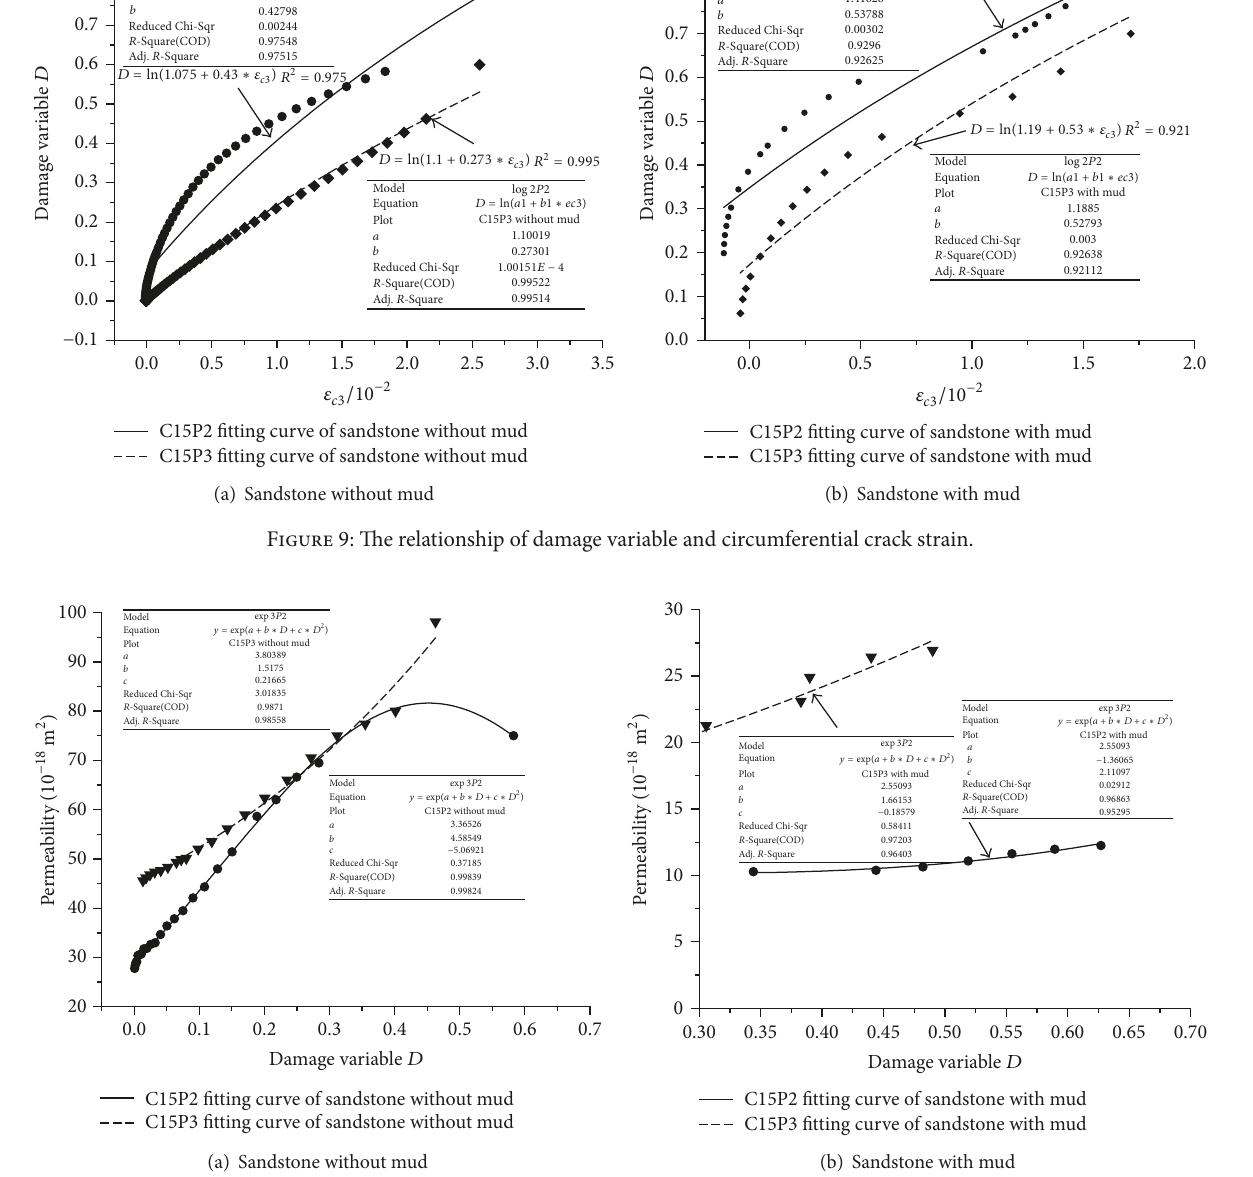
Figure 10: The relationship of the permeability and damage